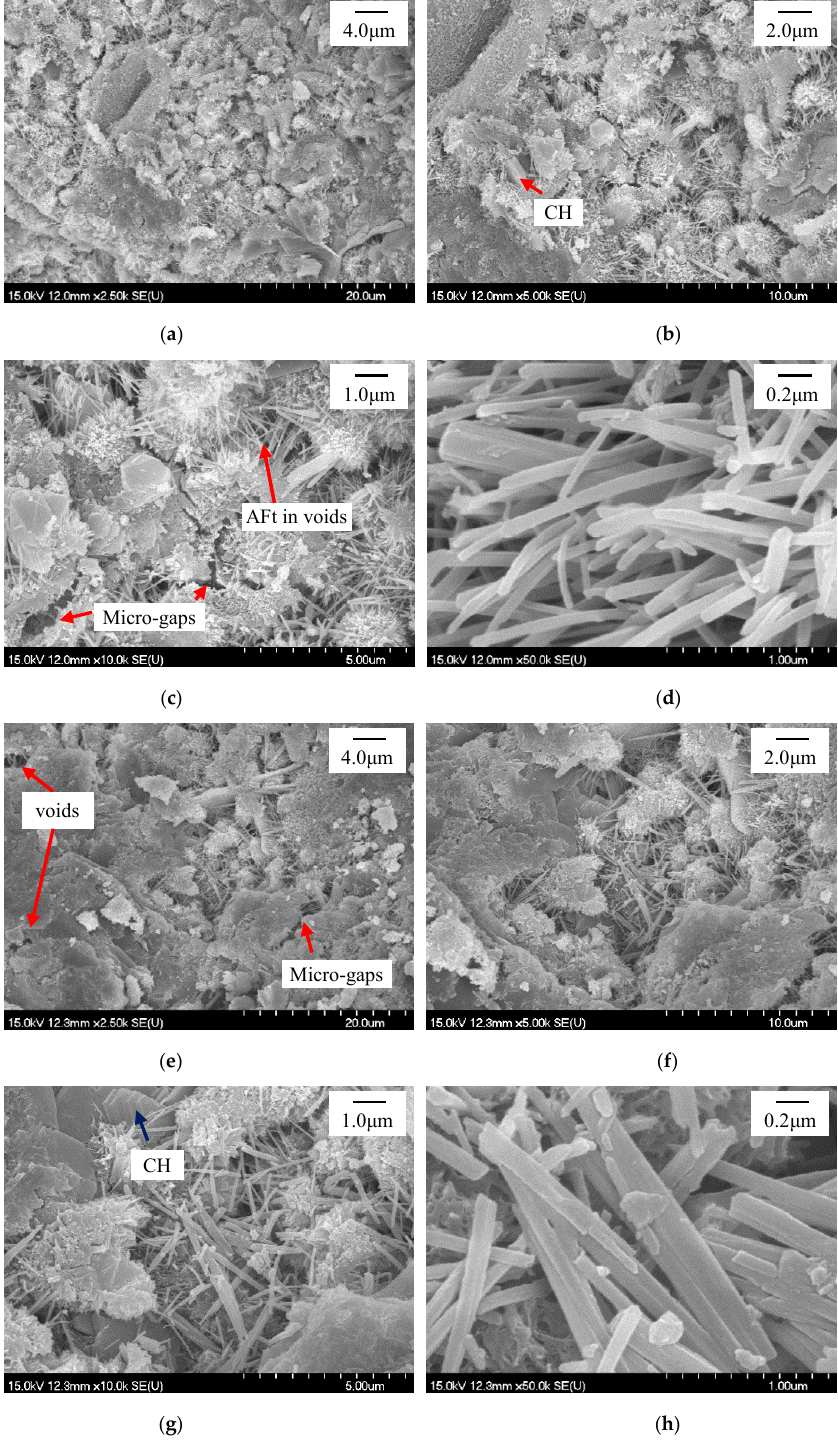
Figure 12. SEM photographs for the blank HCP at T2 and T3. ( a )–( d ) T2, ( e )–( h ) T3.